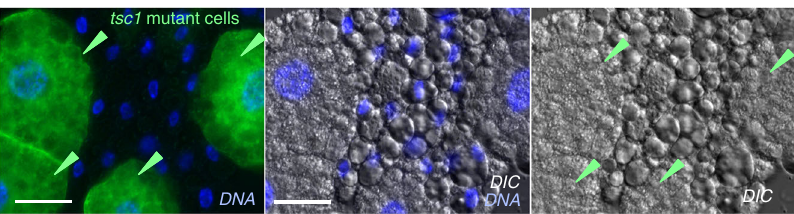
Fig. 7 TORC1 suppression is required for hypoxia-induced modulation of lipid storage. The MARCM system was used to generate GFP-marked tsc1 W240X mutant cell clones in the fat body. Hatched larvae were then either maintained in normoxia or transferred to hypoxia. At the third instar stage, larval fat bodies were fi xed, dissected and mounted on coverslips. Fat bodies were then imaged using DIC microscopy to visualize lipid droplets. Blue = Hoechst DNA dye. Scale bar = 50 μ